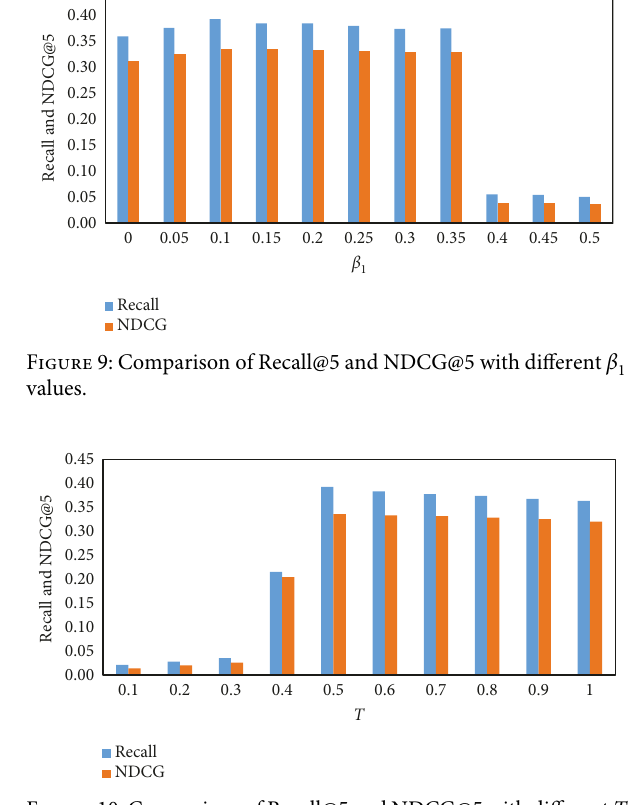
Figure 10: Comparison of Recall@5 and NDCG@5 with different T values. � 0.4, the model performance decreases Figure 9. When β 1